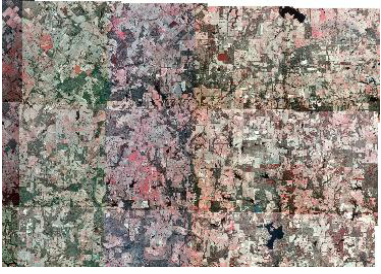
Figure 3. Images before color balancing